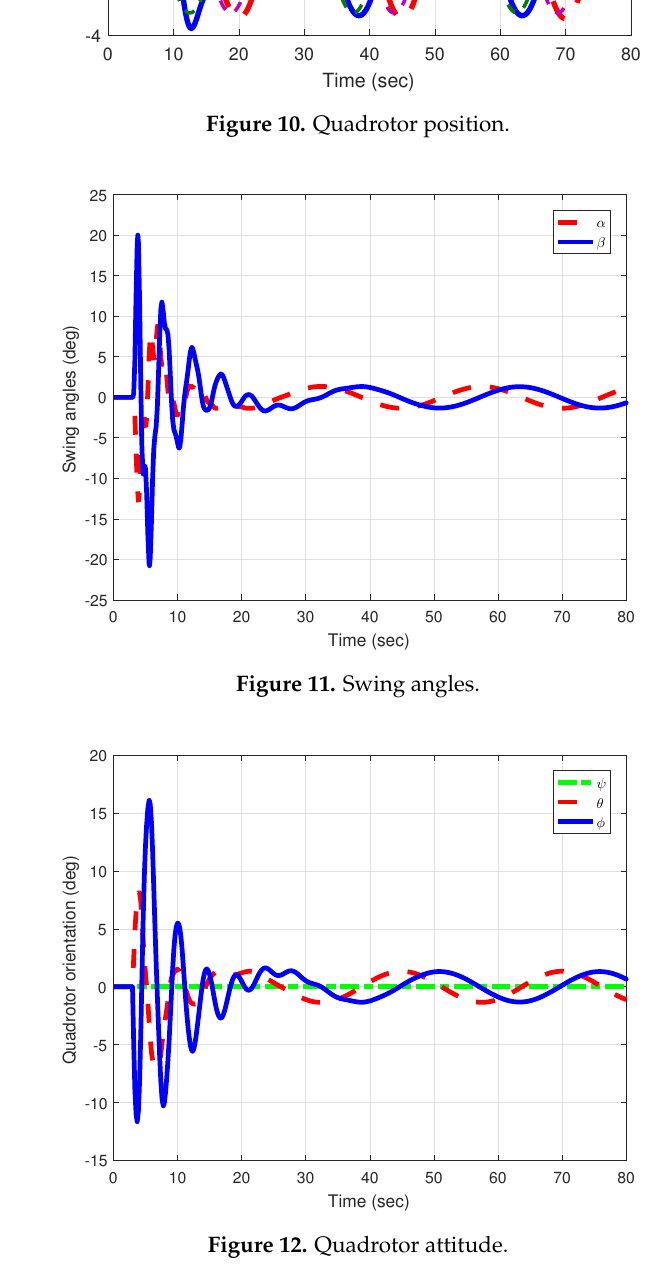
Figure 12. Quadrotor